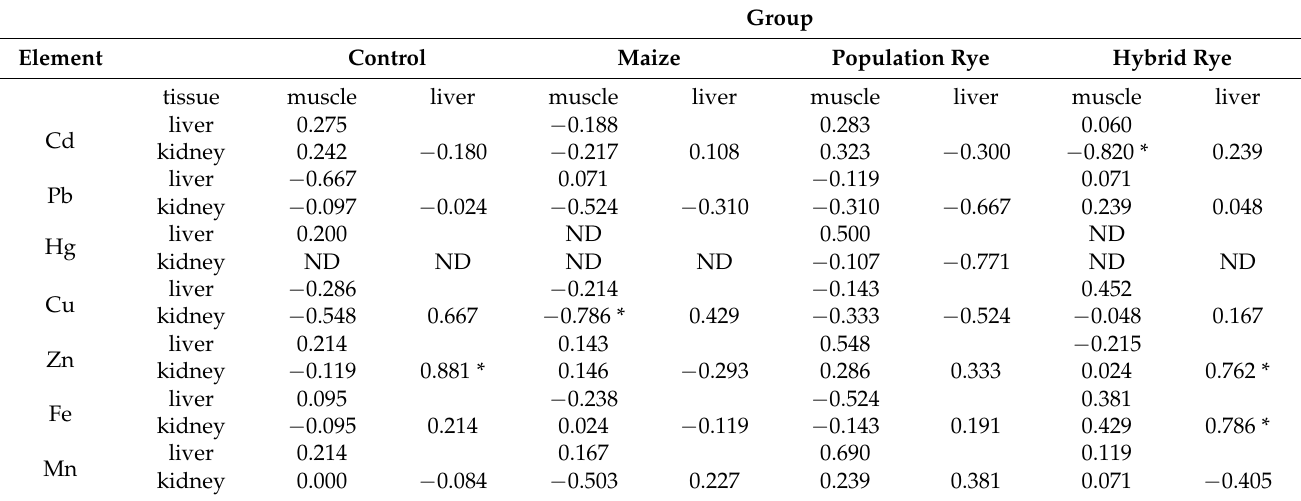
Table 9. The Spearman’s correlation coefficients of heavy metals in the muscles, liver and kidneys of pigs fed control and experimental